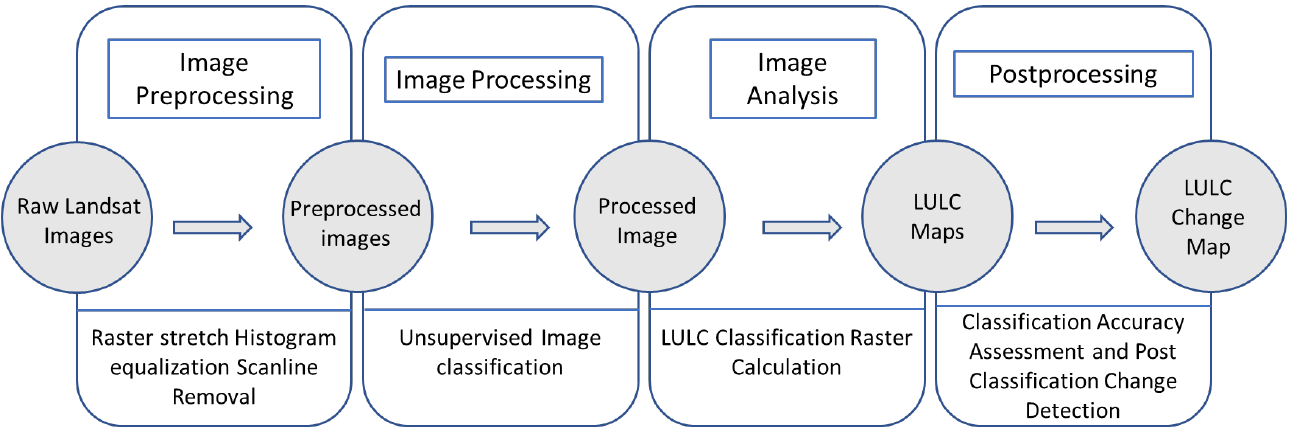
Figure 2. Work flowchart for creating the LULC and LULC change maps.